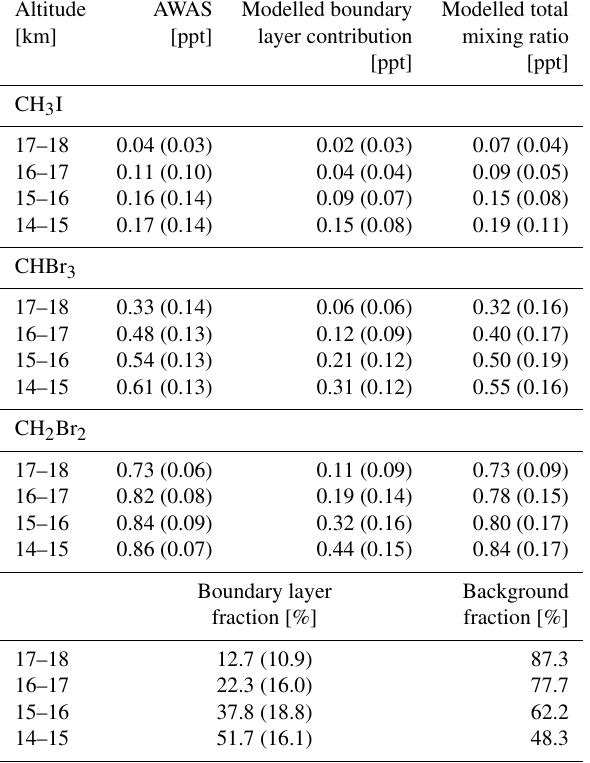
Table 3. ATTREX 2014 all flights. AWAS observations; modelled boundary layer contribution; and the modelled total mixing ratios for CH 3 I, CHBr 3 , and CH 2 Br 2 . The boundary layer and back- ground fractions are also given. Means and standard deviations are given in